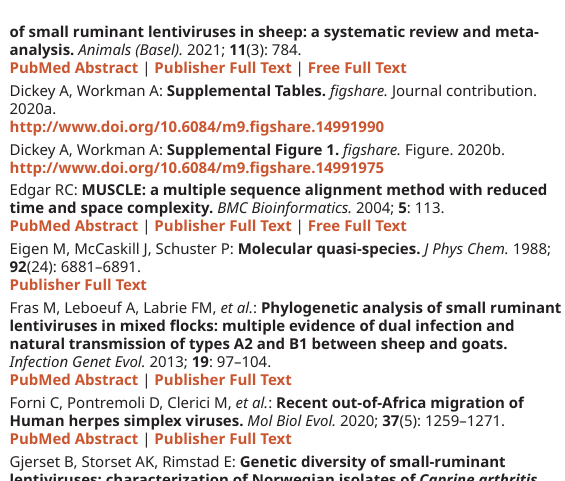
This file contains 23 SRLV subtype A2 genomes ‘painted’ with recipient genomic ‘chunks’ derived from populations of donor genomes. The five donor genome populations in the recombination model were determined using